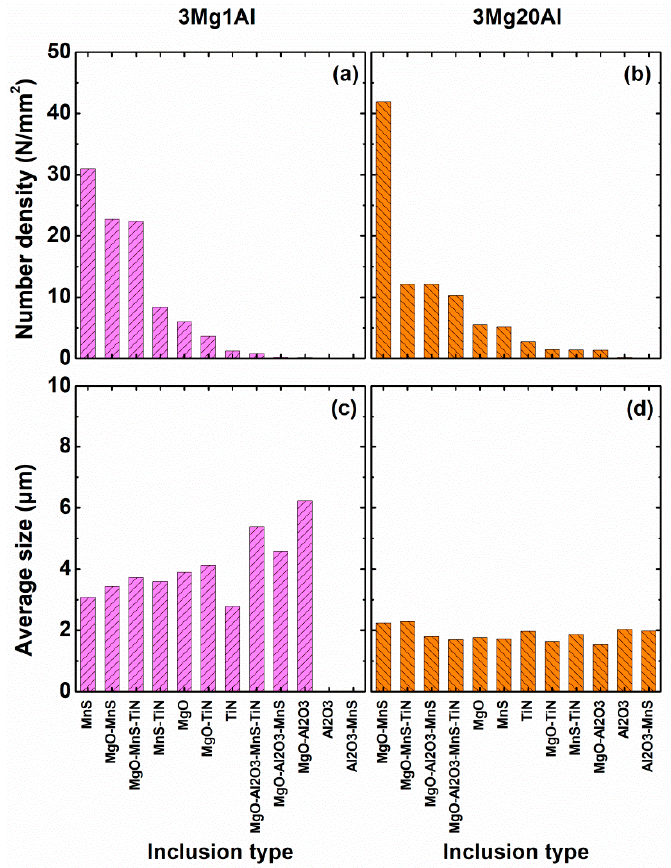
Figure 7. Number density and average size of different types of inclusions in experimental steels.